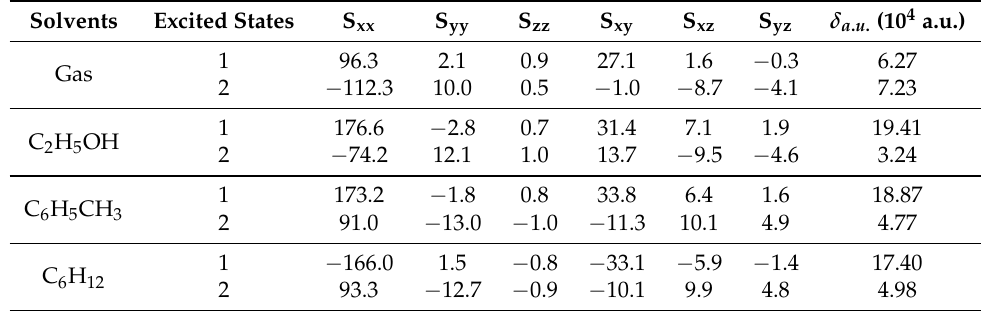
Table 4. The two-photon absorption (TPA) tensor elements S ab and TP transition probability for first and second excited states of D-luciferin molecule in gas and solvent phases.